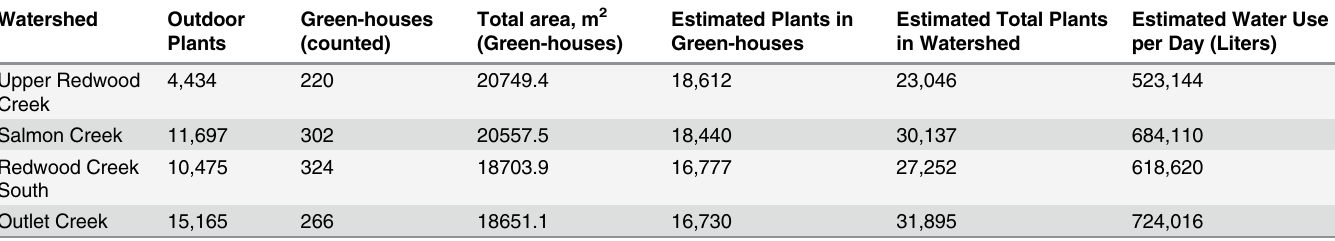
Table 3. Marijuana mapping summary of four watersheds.